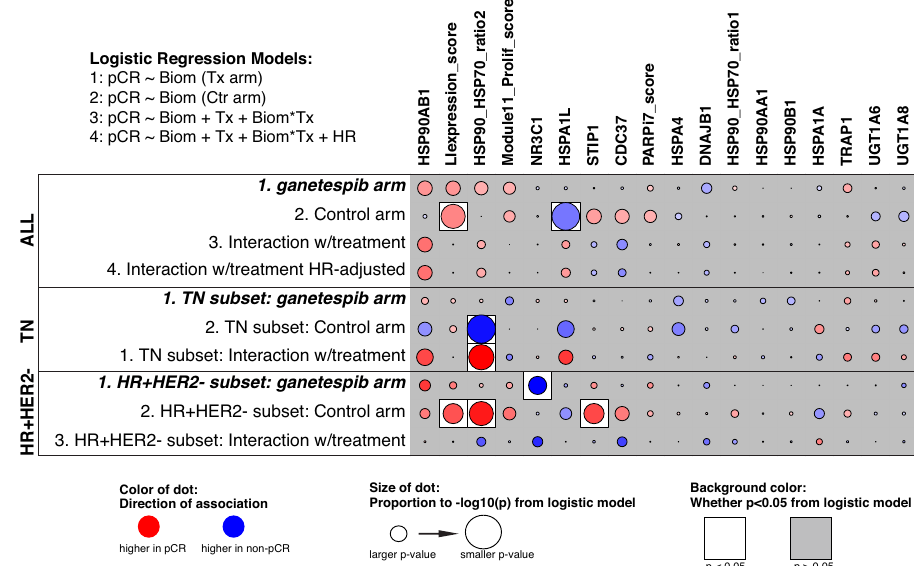
Fig. 4 Analysis of pre-speci fi ed mechanism-of-action gene expression biomarkers for ganetespib response. Association dot-plot showing the level and direction of association between each gene (row) and pCR in the population/model as labeled (columns from right to left): G arm, control arm, interaction with treatment, interaction with treatment in a model adjusting for HR status; and analysis limited to the TN and HR + HER2- subsets. Key = red/blue dot indicates higher/lower levels ~ pCR; size of dot ~ strength of association (1/p likelihood ratio test), with dark outline/white background indicating p < 0.05 (likelihood ratio test) and gray background indicating p > 0.05 (likelihood ratio test). All biomarkers were assessed at the pre-treatment time